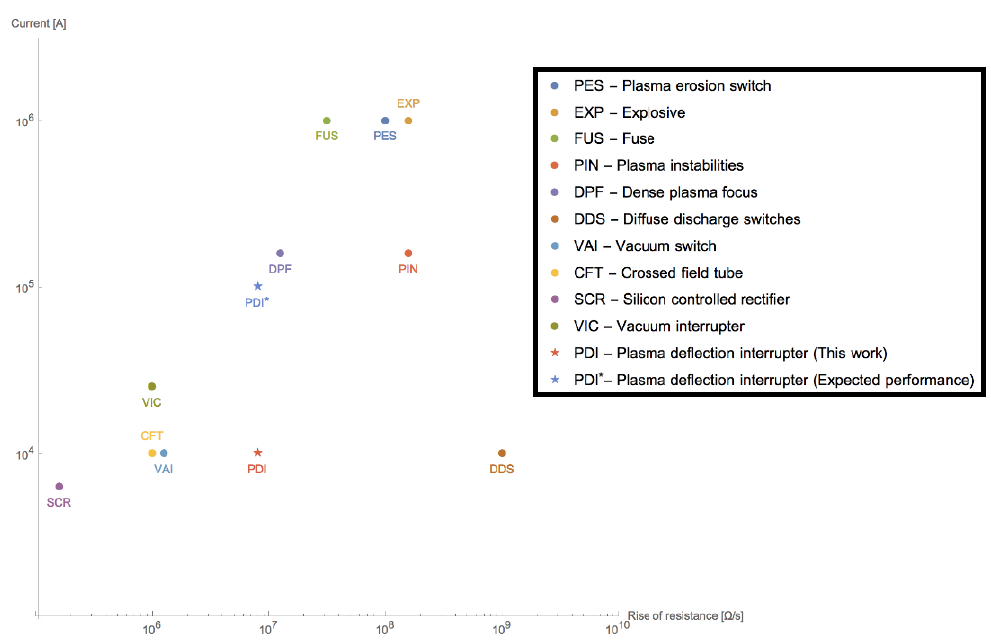
Figure 1. Summary of pulsed power opening switches, adapted from [8]. This current work has been included.